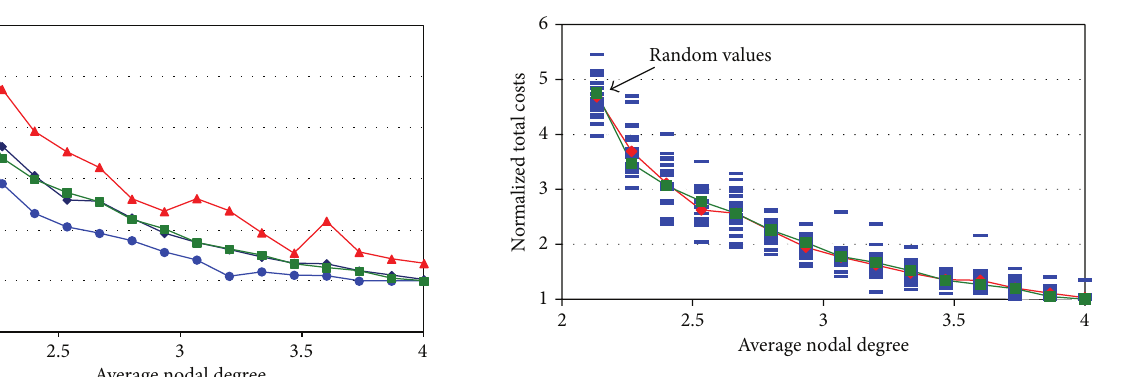
Figure 8: Normalized SBPP total costs of random networks with average and network family.